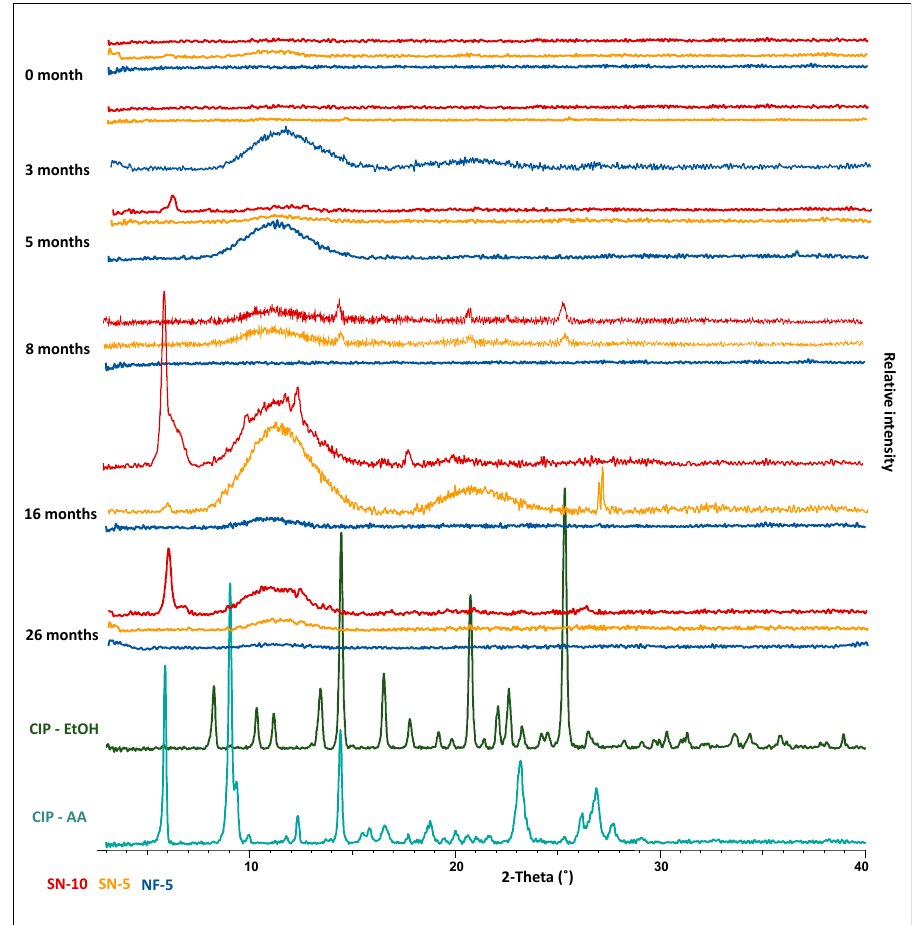
Figure 9. XRPD results of the 26-month stability study. The nanofiber formulations measured at different time points are colored as follows: red and yellow for single-nozzle electrospinning (SN-10 and SN-5), and blue for nozzle-free electrospinning (NF-5). XRPD patterns detected from crystallized ciprofloxacin from ethanol (CIP-EtOH) and acetic acid (CIP-AA) are green. In terms of crystallinity, better stability was observed for samples produced using nozzle-free electrospinning, as the drug was amorphous throughout the 26 months. In the case of nozzle-based formulations, the ciprofloxacin re-crystallized by the 5th and 8th months.